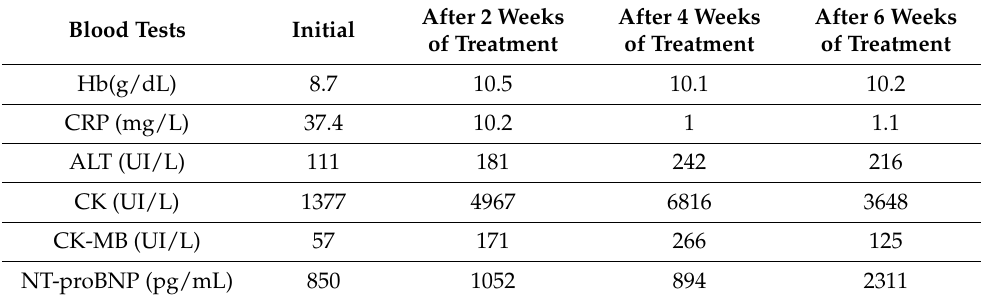
Table 3. Evolution of blood tests throughout the therapy